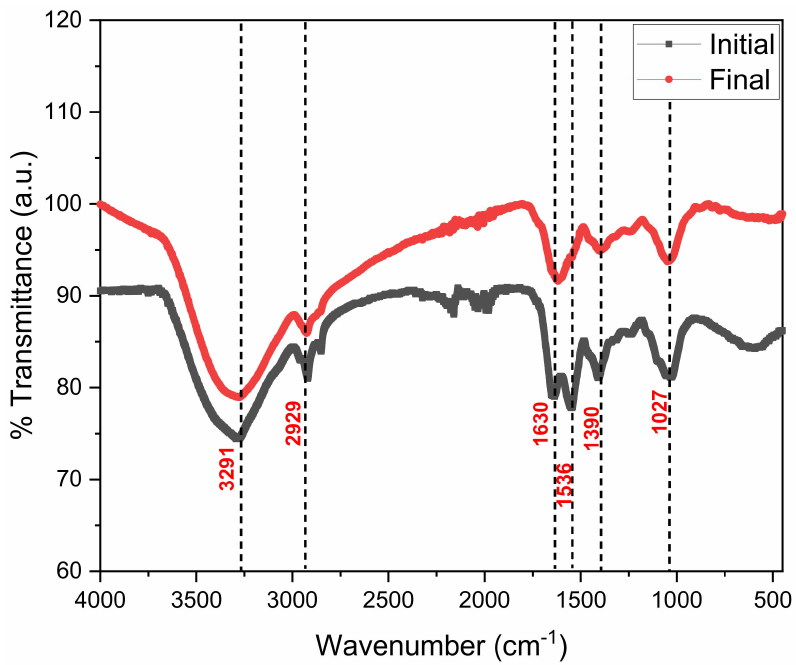
Figure 5. FTIR spectrophotometry of the initial and final onion